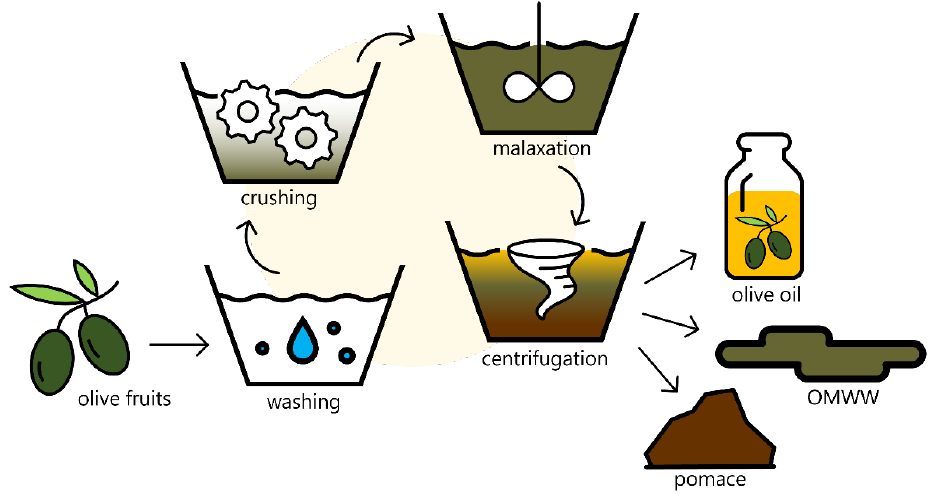
Figure 2. Scheme of olive oil production.